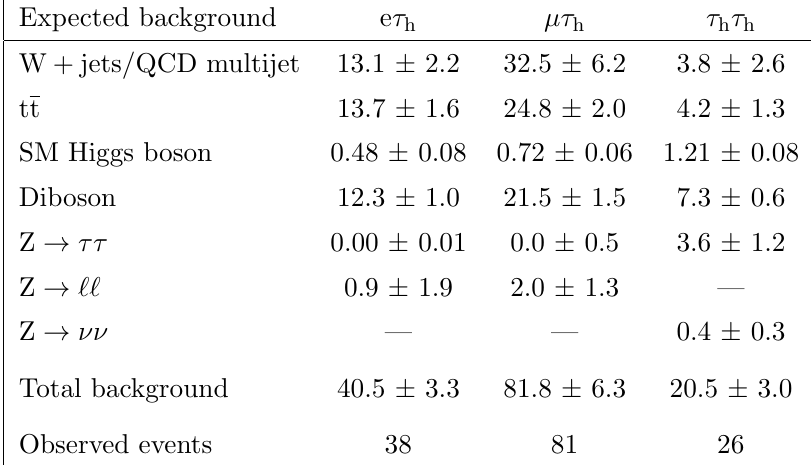
> 260 GeV, in the T